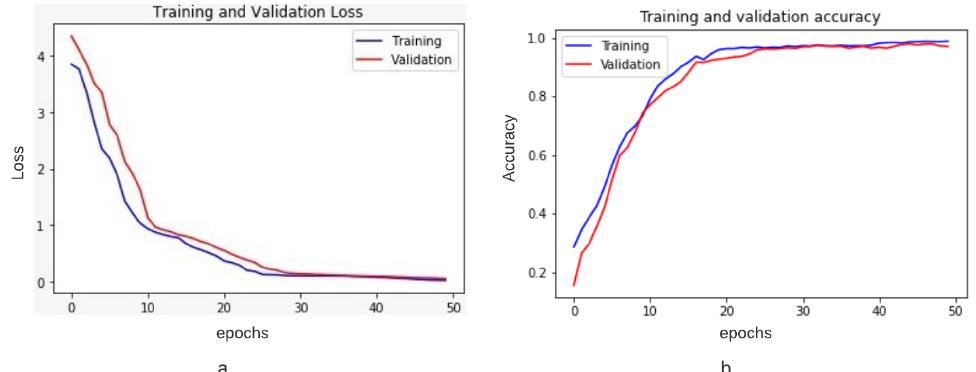
Figure 9. ( a ). Training and validation loss plot and ( b ). Training and validation accuracy plot. Both the plots show consistency in decreasing loss and increasing accuracy on the given dataset. Training is shown in blue colour, and validation is shown in red colour.